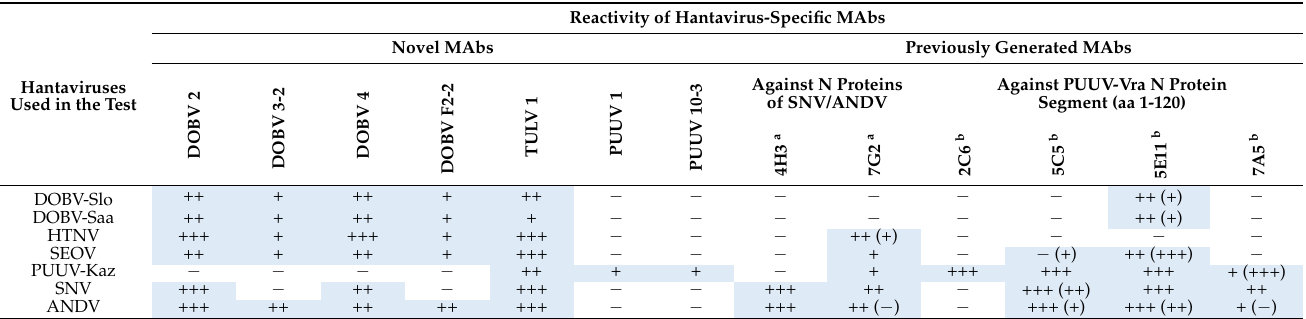
− + ( − ) Dobrava-Belgrade orthohantavirus , genotype Dobrava, strain Slovenia (DOBV-Slo); genotype Saaremaa (DOBV-Saa); Hantaan orthohantavirus (HTNV); Seoul orthohantavirus (SEOV); Puumala orthohantavirus strain Kazan (PUUV- Kaz); Sin Nombre orthohantavirus (SNV); Andes orthohantavirus (ANDV). The symbols “+”, “++” and “+++” refer to the intensity of the fluorescence signal; negative reactions are indicated as “ − ”. a , b —MAbs described by [47,49], respectively. If the current reactivity differs from that described previously in [47], it is indicated before the